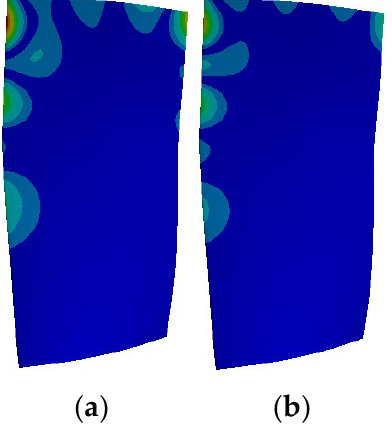
Figure 24. 54 EO displacement amplitude of R1 rotor blade. ( a ) C# ( b ) M#.